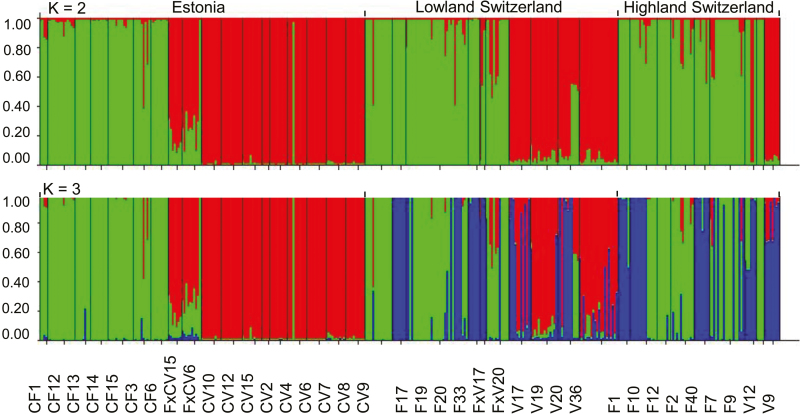
Bar graph illustrating STRUCTURE analysis of C. flava (CF/F), C. viridula (CV/V) and C. × subviridula (FxCV/FxV) populations from three studied regions Estonia, Highland and Lowland Switzerland. According to the ΔK method, the Bayesian analysis identified two genetic clusters (top, A), while three clusters were found based on observed likelihood values (bottom, B). Each vertical bar represents an individual with coloured partitioning according to genetic clusters. Black vertical lines divide populations. Population names are as in Table 1.